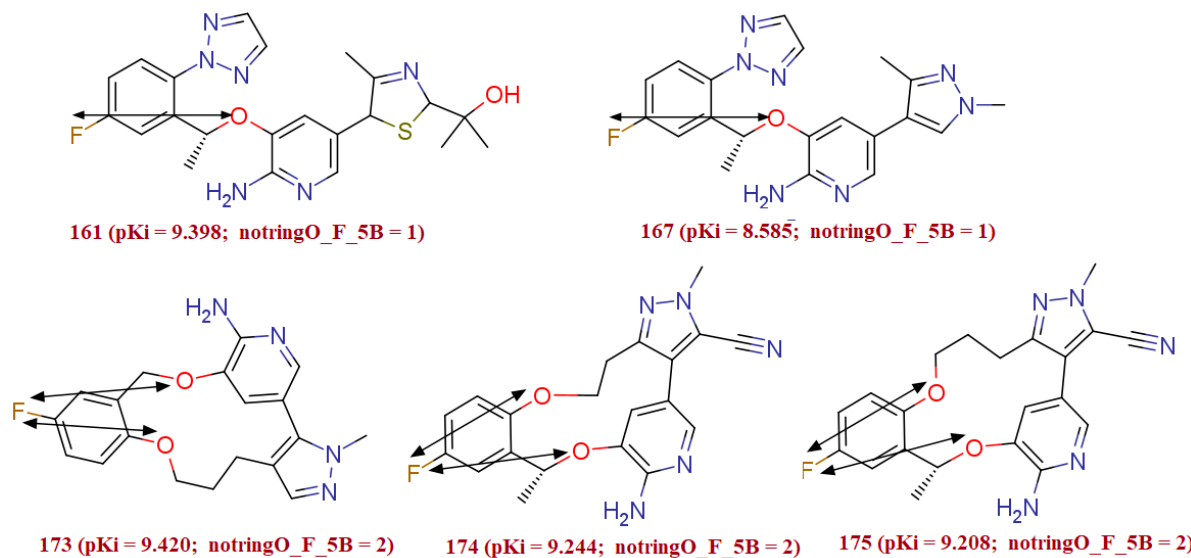
Figure 5. Illustration of molecular descriptor notringO_F_5B for the molecules 161 and 173, 174 and 175, and 167. 175, and